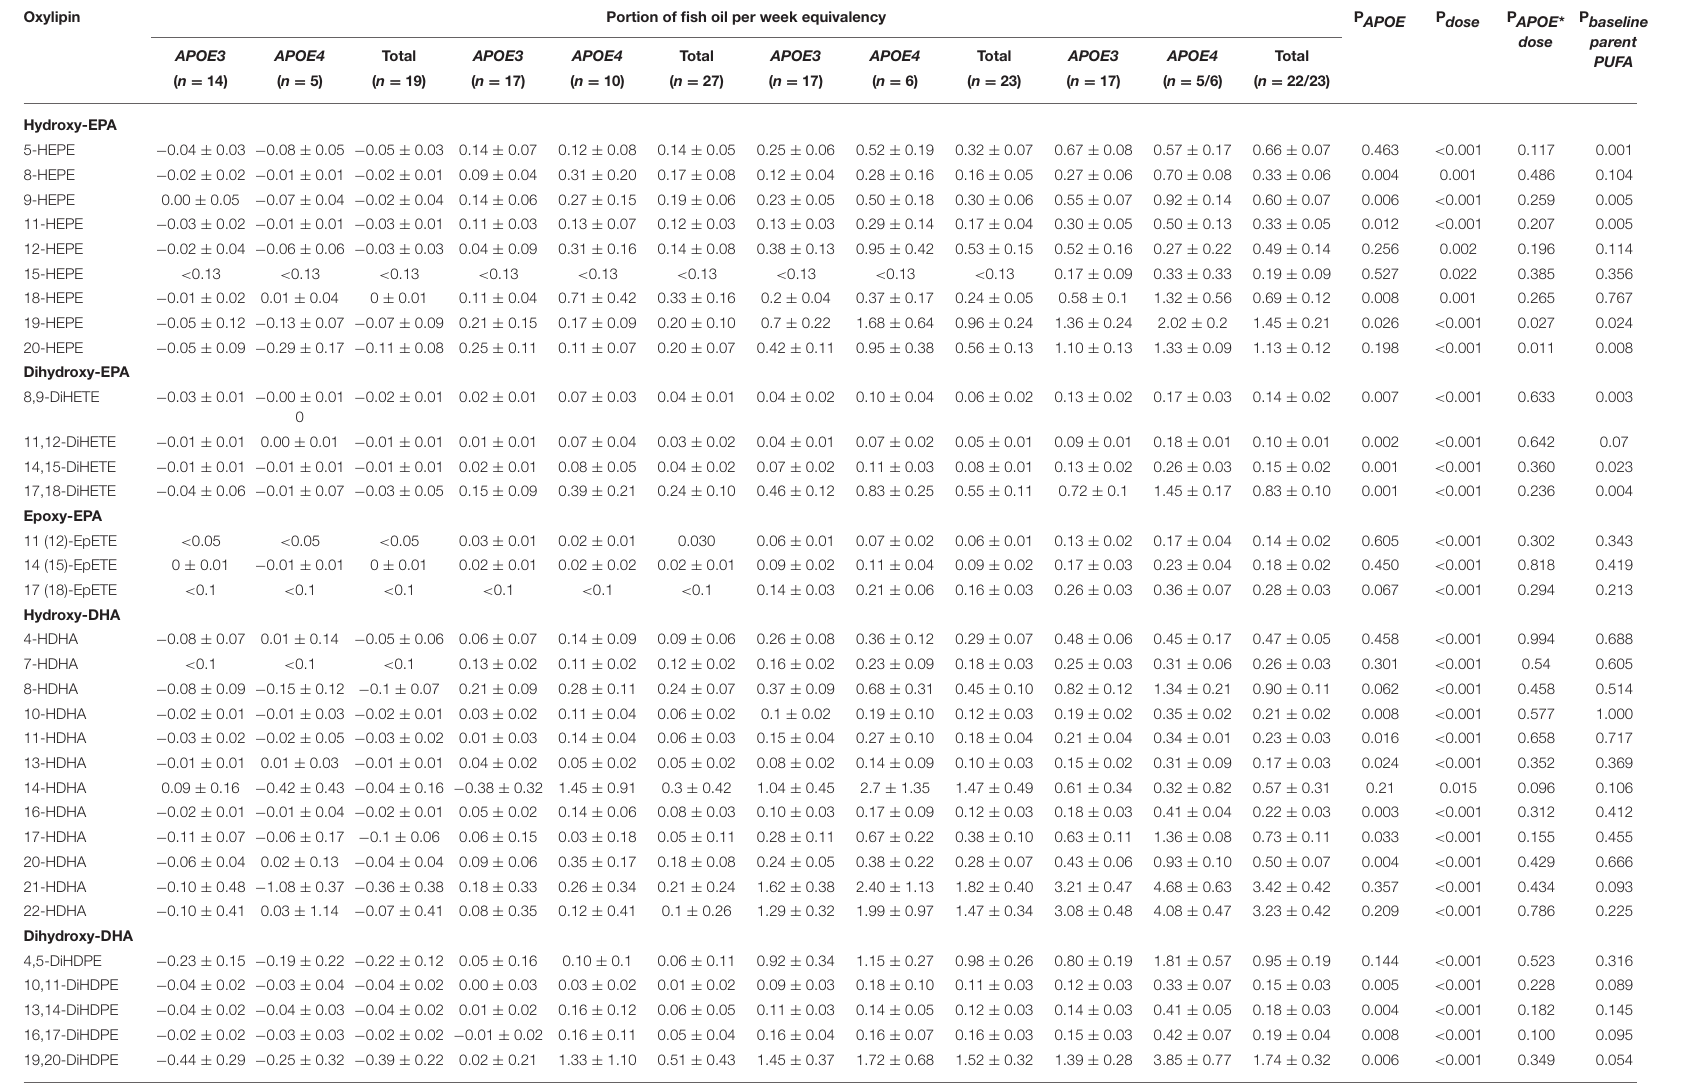
TABLE 4 | Change from baseline in plasma oxylipins (nM) after 12 months of supplementation with n-3 PUFAs equivalent to 0, 1, 2, and 4 portions of fatty fish per week.